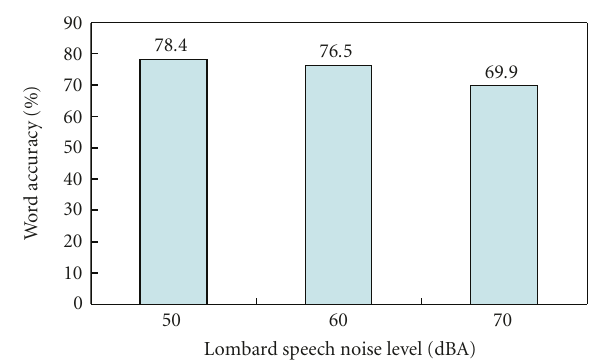
Figure 14: Nonaudible murmur recognition using Lombard data and a multilevel common HMM